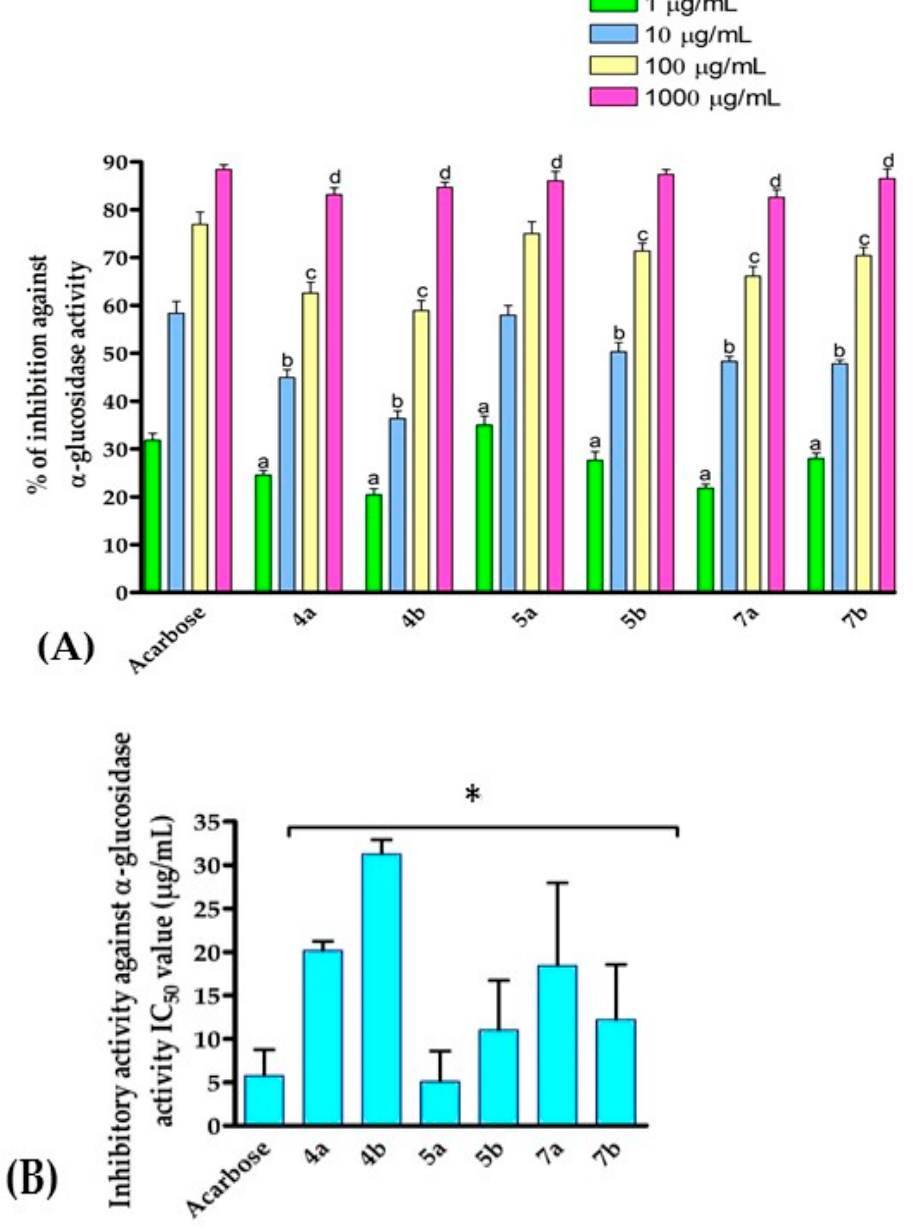
Figure 3. Inhibitory activities of compounds 4a – b , 5a – b , and 7a – b against α -glucosidase activity (n = 4). ( A ) Percentage of inhibition. ( B ) IC 50 values ( µ g/mL). Data are presented as mean ± SD. a p < 0.05 versus acarbose at concentration 1 µ g/mL, b p < 0.05 versus acarbose at concentration 10 µ g/mL, c p < 0.05 versus acarbose at concentration 100 µ g/mL, d p < 0.05 versus acarbose at concentration 1000 µ g/mL,* p < 0.05 versus acarbose for the IC 50